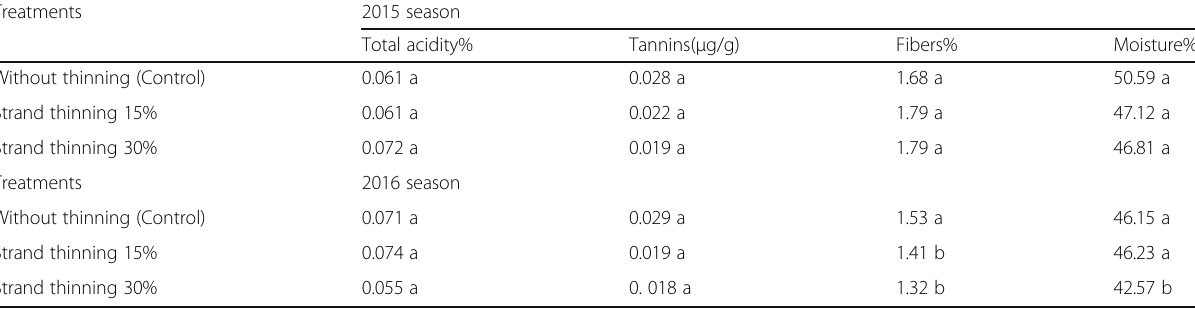
Table 5 Effect of strand thinning treatments on total acidity%, tannins ( μ g/g), fibers % and moisture % of Khadrawi date palm fruit at rutab stage during 2015 & 2016 seasons